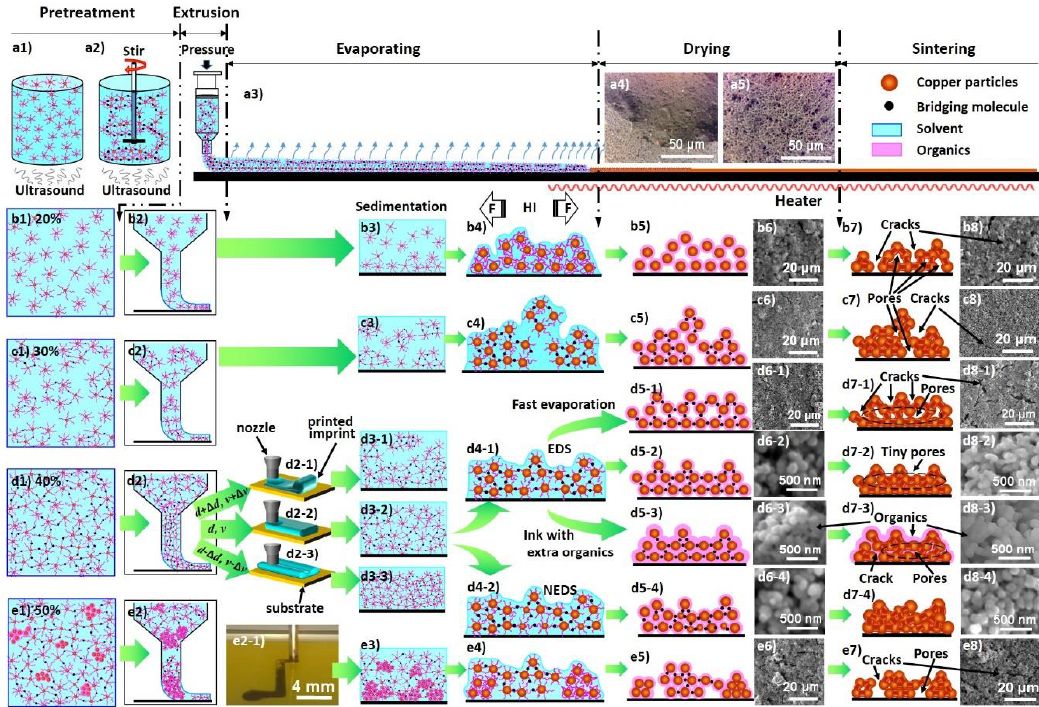
Figure 6. (color online only) Schematic pictures of the printing procedures influenced by various key factors and corresponding microstructures obtained. ( a1 ) and ( a2 ) Particle configurations in the ink pretreated with and without the mechanical agitation, respectively. ( a3 ) The printing procedure from extrusion to sintering. ( a4 ) and ( a5 ) Optical microscope images of the interconnect structures printed on glass substrates and dried in air for 5 min with and without the mechanical-ultrasonic combined pretreatment, respectively. ( b1 ) – ( b8 ), ( c1 ) – ( c8 ), ( d1 ) – ( d8 ) and ( e1 ) – ( e8 ) Particle